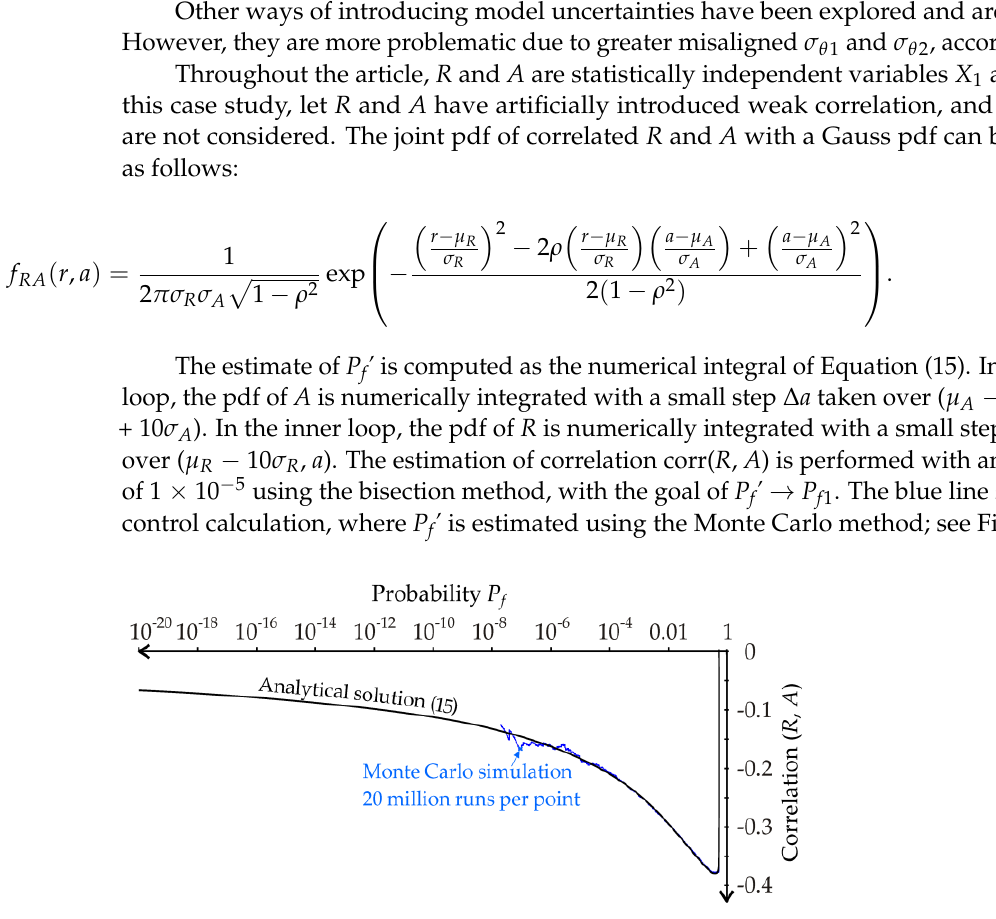
Figure 9. Course of artificial correlation between R and A — case study 3.